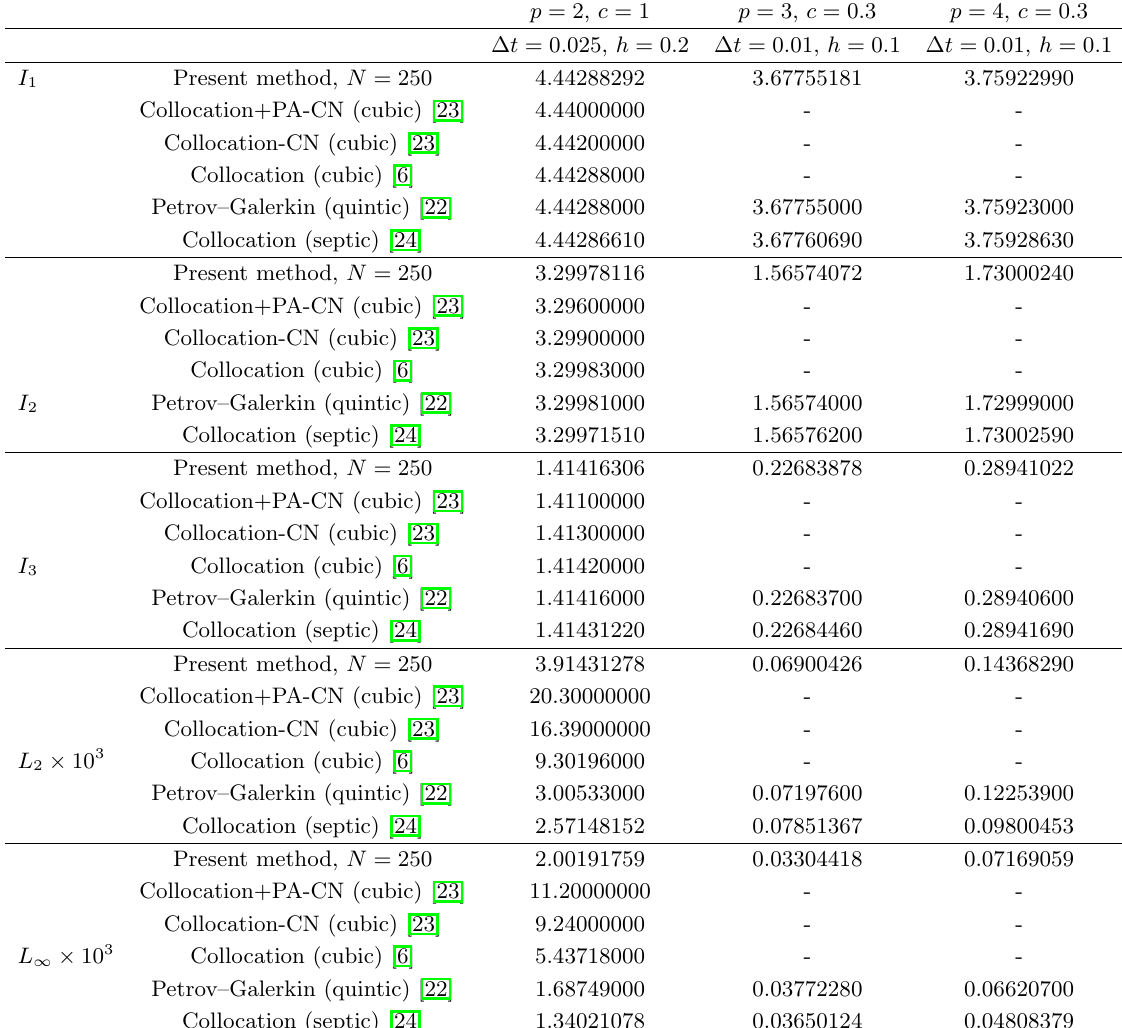
Table 7. Comparison of the results on 0 ≤ x ≤ 100 for µ = 1 at t = 10. p = 2, c = 1 p = 3, c = 0 .